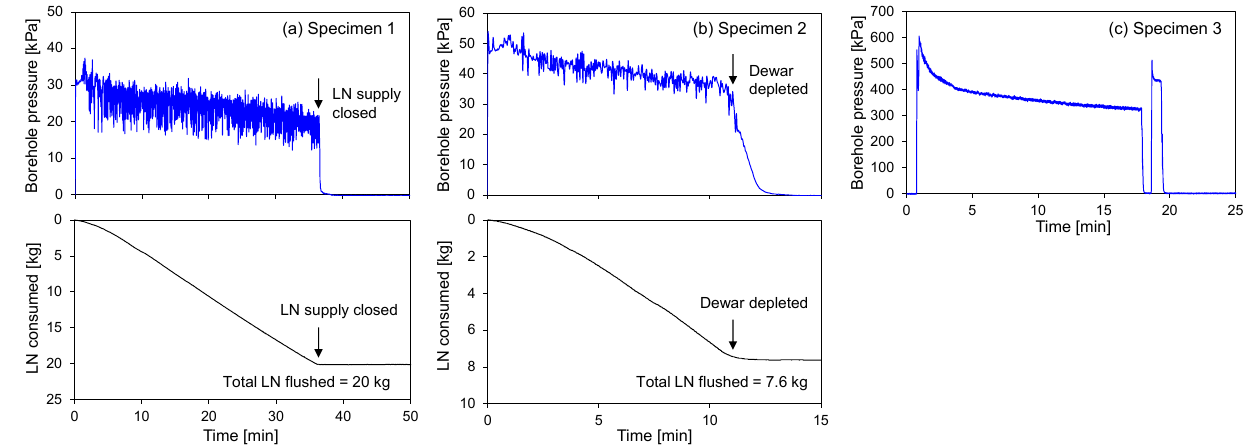
Figure 4. Borehole pressure and LN consumption during the tests.